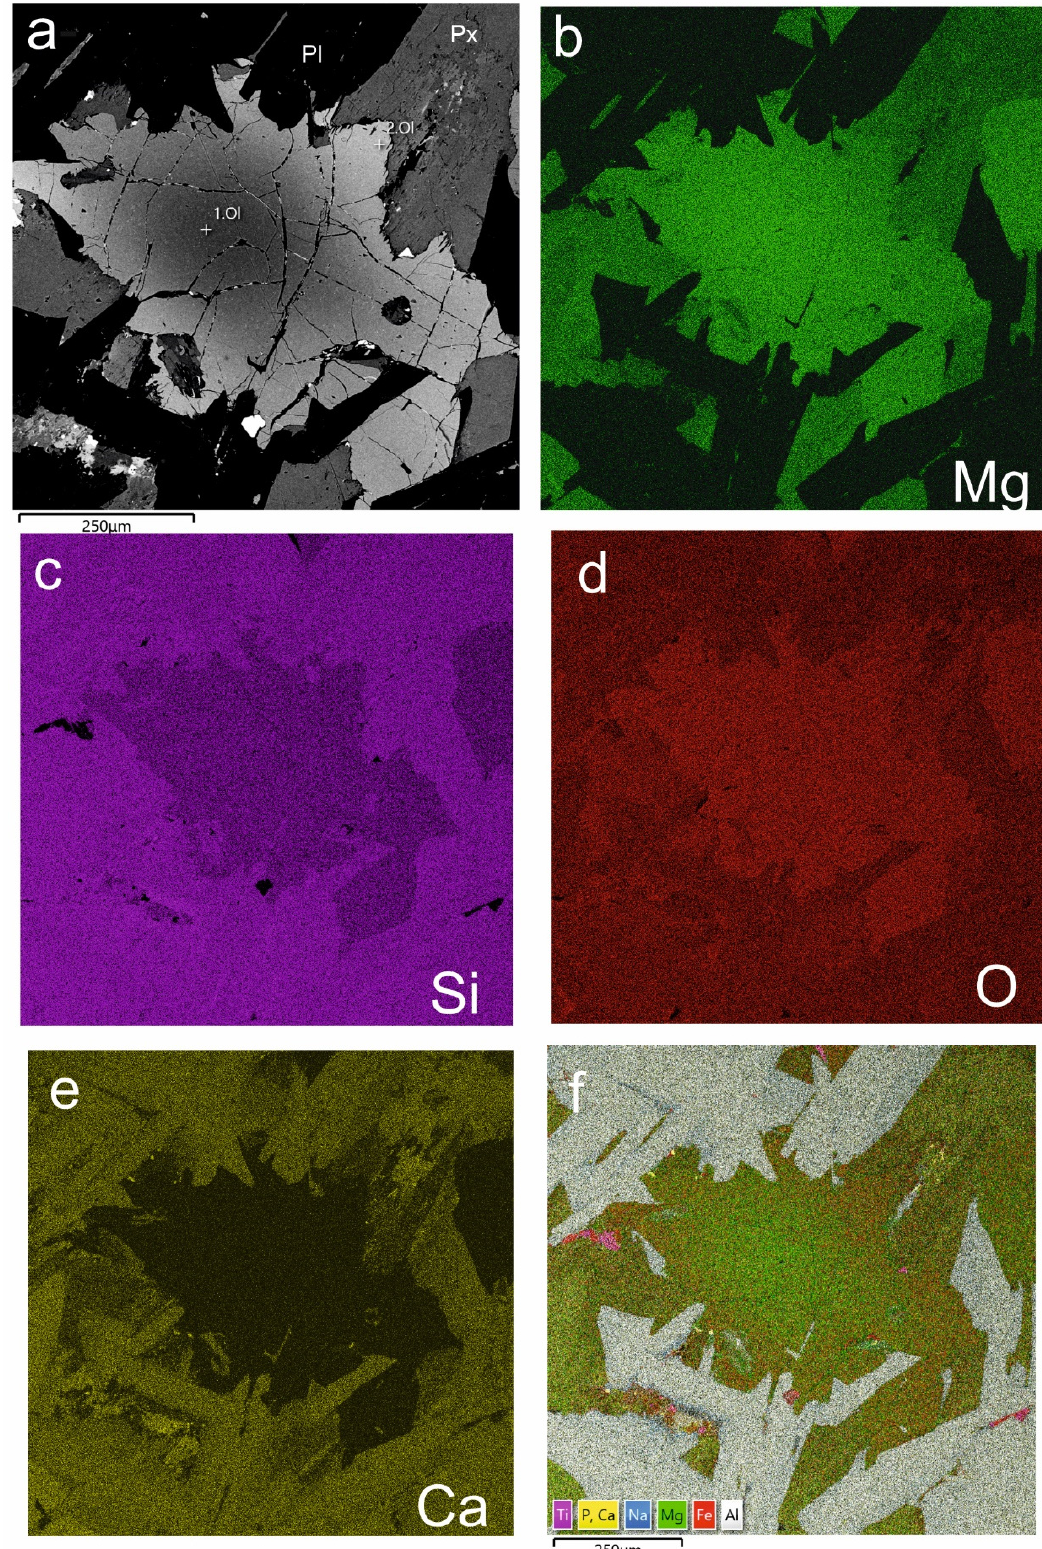
Figure 5. Zoned olivine (sample MD-48/1205). ( a ) back-scattered electron image, ( b – f ) images in characteristic X-Ray: ( b ) Mg K L ; ( c ) Si K L ; ( d ) -O K L ; ( e ) Ca K L ; ( f ) multi elements (Tescan Mira